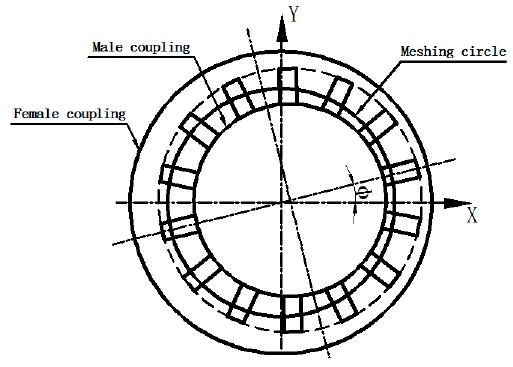
Figure 2. Schematic diagram of the gear coupling.